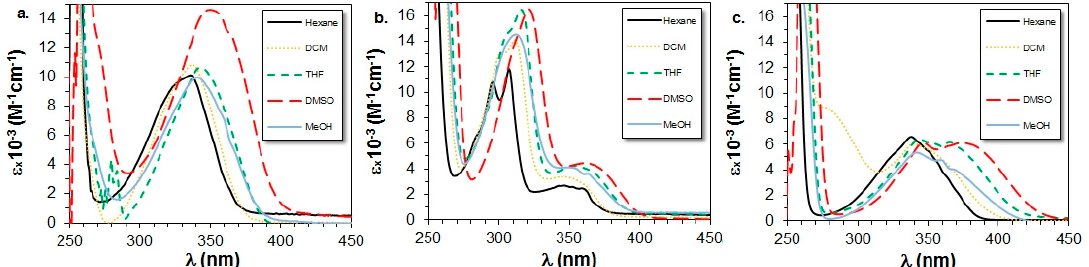
Figure 1. The UV-Vis spectra of the 1,4-ICAN ( a ), 2,6-ICAN ( b ), and 1,5-ICAN ( c ) isomers recorded in different solvents. Table 1. The maximum absorption wavelengths ( λ Abs ) and the molar absorption coe ffi cients at λ Abs ( ε ) determined in various solvents for the 1,5-ICAN, 1,4-ICAN, and 2,6-ICAN isomers. The dielectric constants of the solvents ( ε r ) are listed next to the solvent